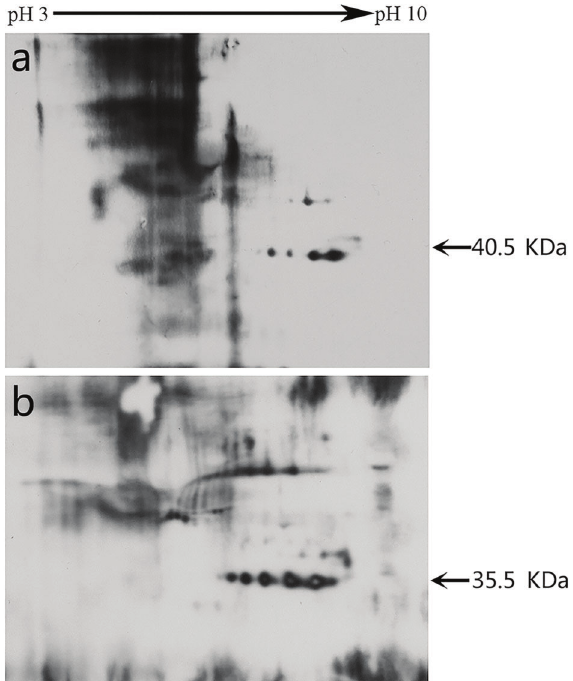
Figure 4. The crude antigen of Echinococcus granulosus cyst fl uid (EgCF) proteins separated by 2-DE was transferred to the nitrocellulose membrane and probed with sera of patient T1. a , IgE immunoblotting was visualized using HRP-labeled mouse anti-human IgE; b , IgG1 immunoblotting was visualized using HRP-labeled mouse anti-human IgG1. The sizes of the prominent proteins in kDa are shown on the right-hand side of the fi gure. 2-DE, two-dimensional gel electrophoresis; IgE, immunoglobulin E; IgG1, immunoglobulin